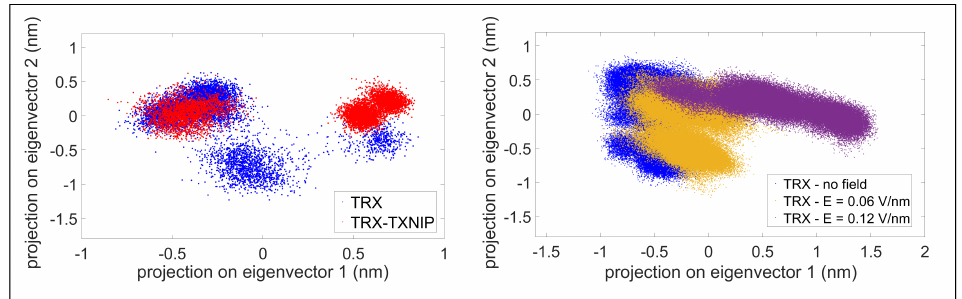
Figure 3. ( left ) PCA comparis on between TRX and TRX-TXNIP (as reported in Figure 2a); ( right ) PCA for the C- α of TRX: no field (blue), E = 0.06 V/nm (yellow), E = 0.12 V/nm (violet).